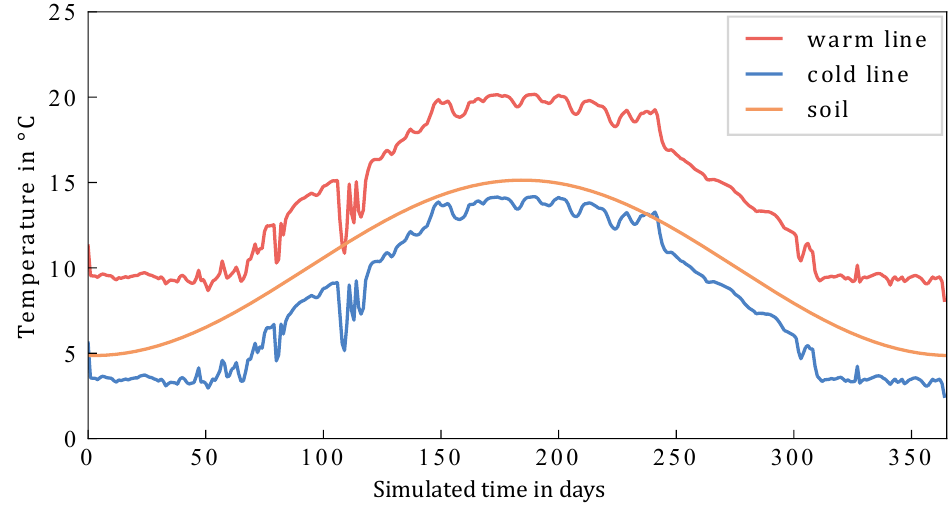
Figure 19. Temperature of warm and cold line at cluster C9 and soil temperatur in depth of 2